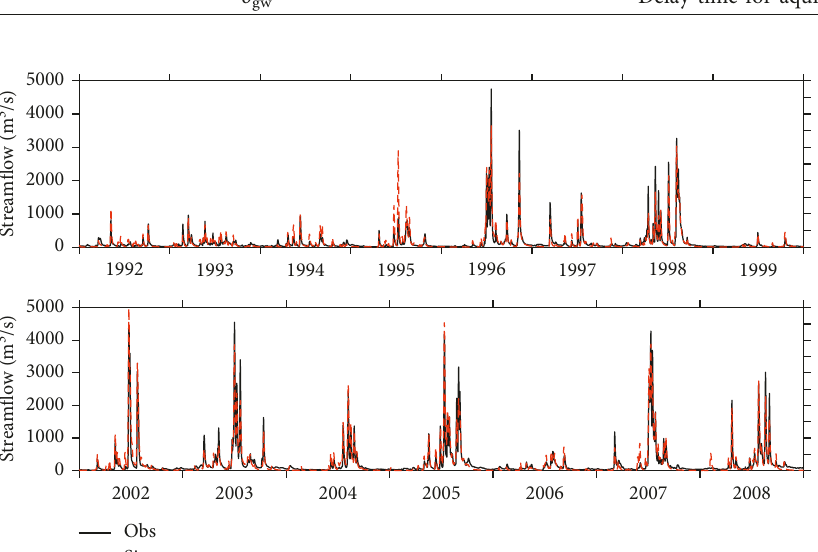
Figure 4: The observed (Obs) and simulated (Sim) daily runoff at the outlet (Huaibin) of the upper Huai River basin over the